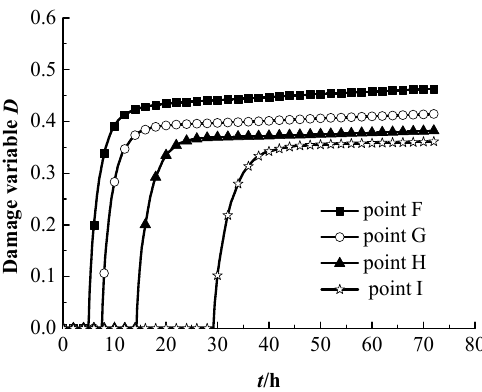
Figure 13. Curves of the damage variable with time at different positions.